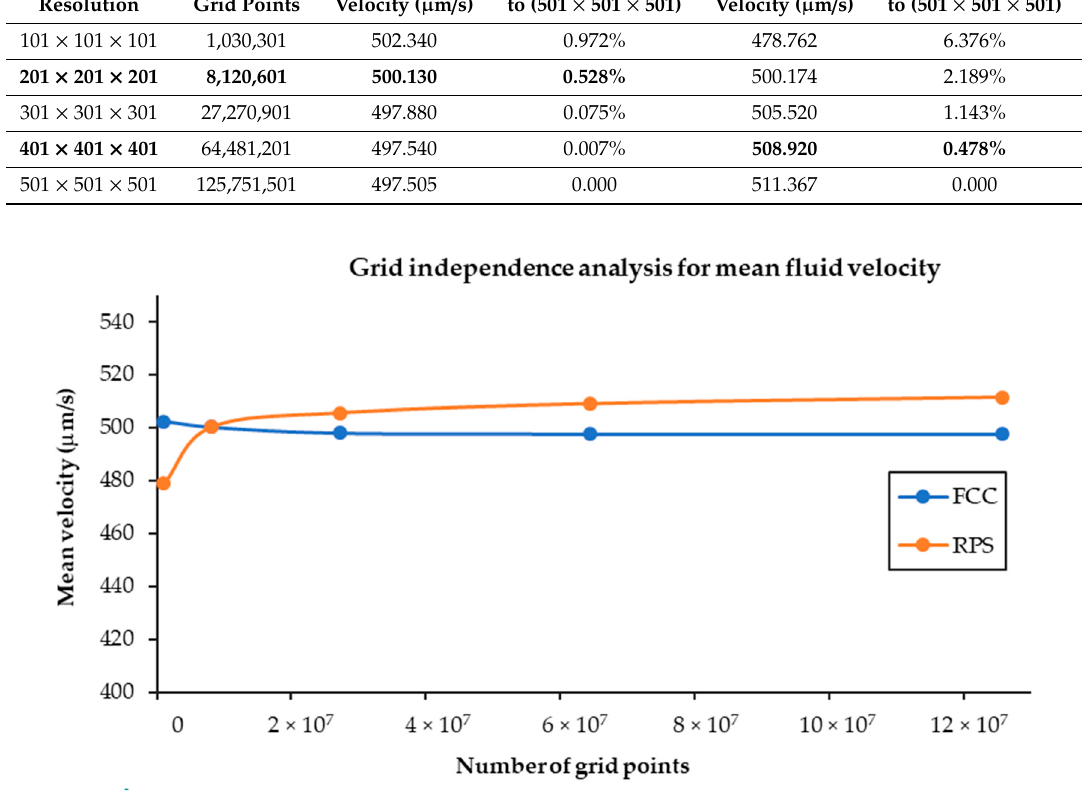
Figure A1. The effect of the number of mesh points on the accuracy of the mean fluid velocity of the LBM flow field for FCC and RPS.